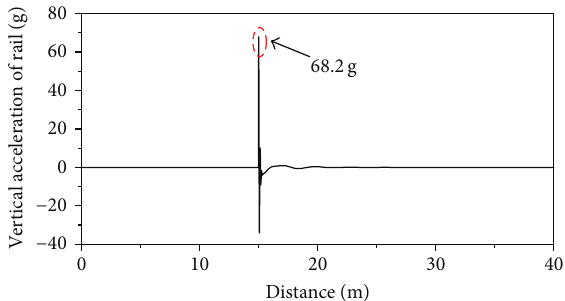
Figure 10: Vertical acceleration of rail in time domain.